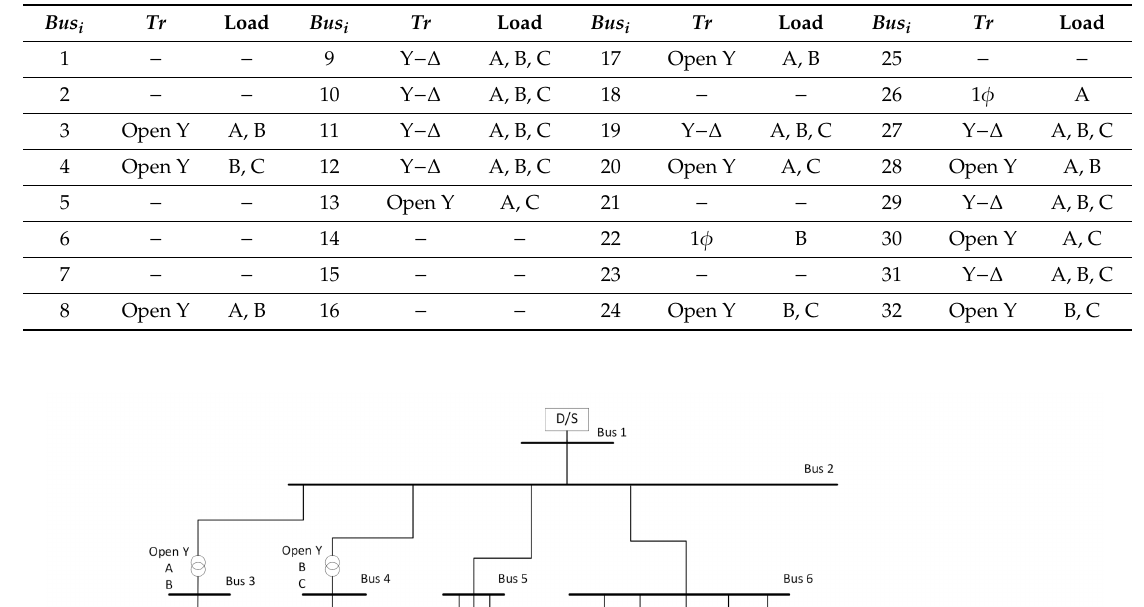
Table 2. The connected status of the distribution transformer.